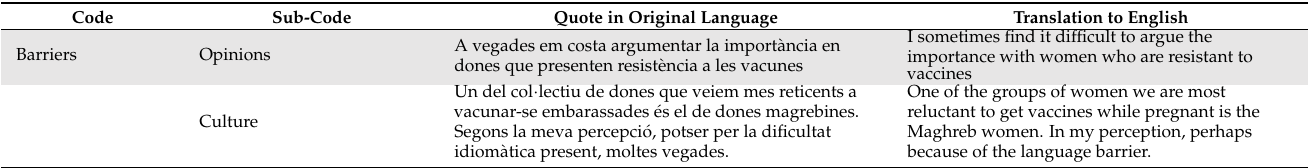
Table A2. Categories for healthcare workers’ acceptability of COVID-19